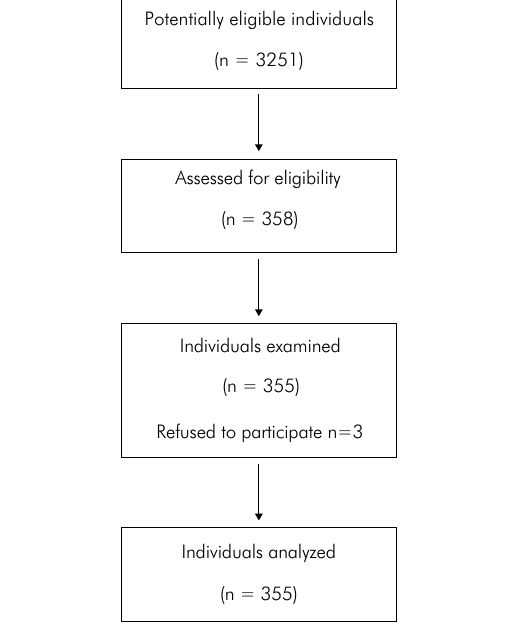
Figure 1. Number of participating students at different phases of the study.